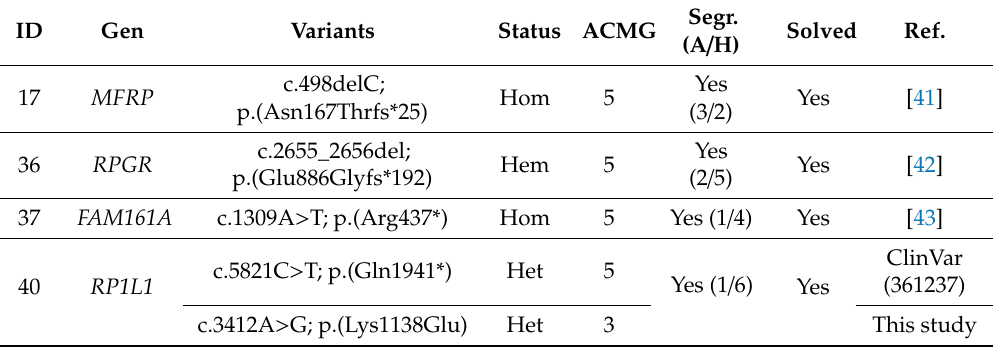
Table 2. Likely pathogenic mutations detected in IRD genes by clinical exome